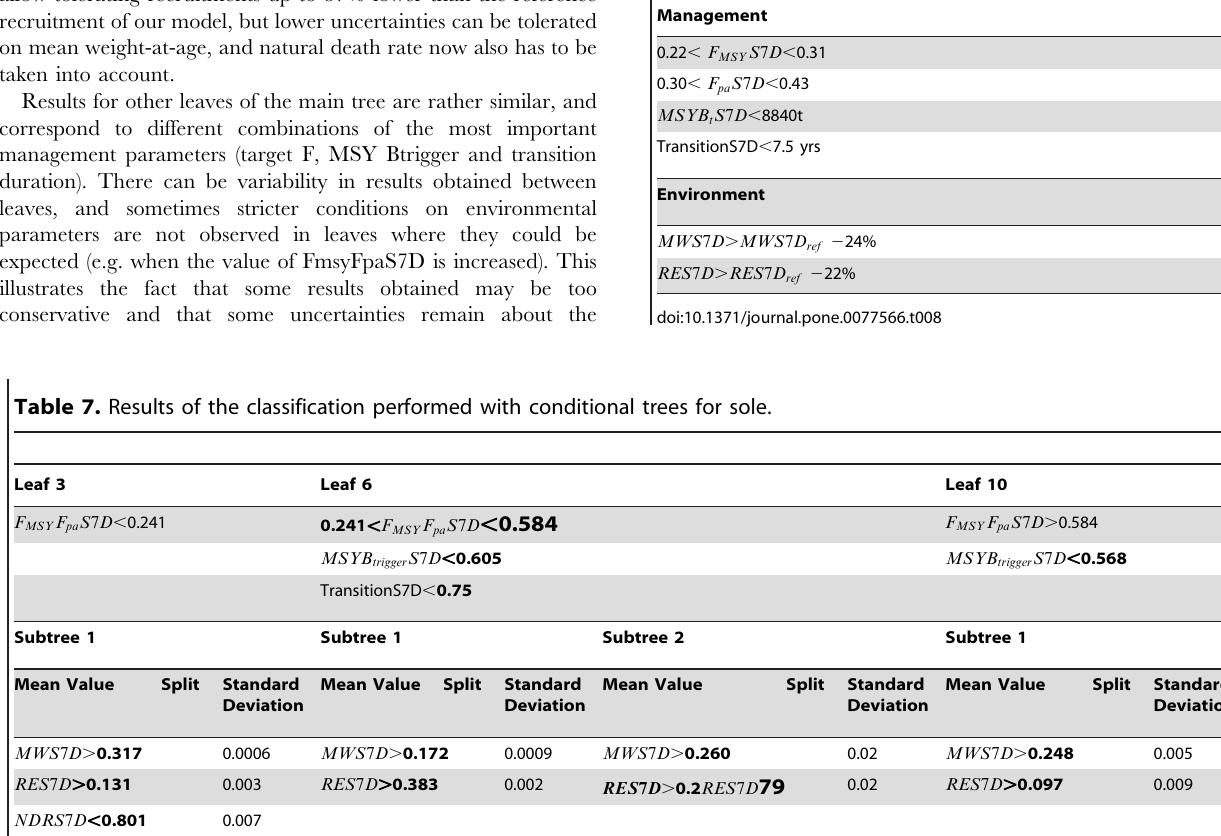
Table 8. Management parameters values identified from leaf 6 and environmental variability they allow dealing with. For sole in subarea